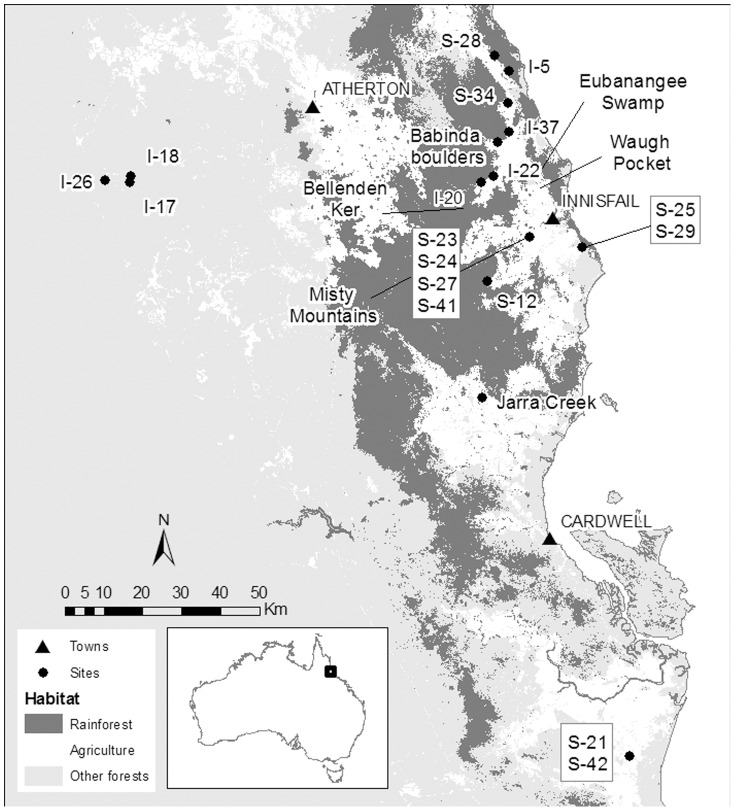
Study Area showing capture sites of feral pigs in this study.Feral pigs captured in cane plantations are denoted with an S, while those from interface habitats are denoted with an I. Pigs captured in Jarra Creek, Misty Mountains, and Babinda Boulders are deemed captured in rainforest.